Question: Briefly state, in one sentence, what is plotted here.
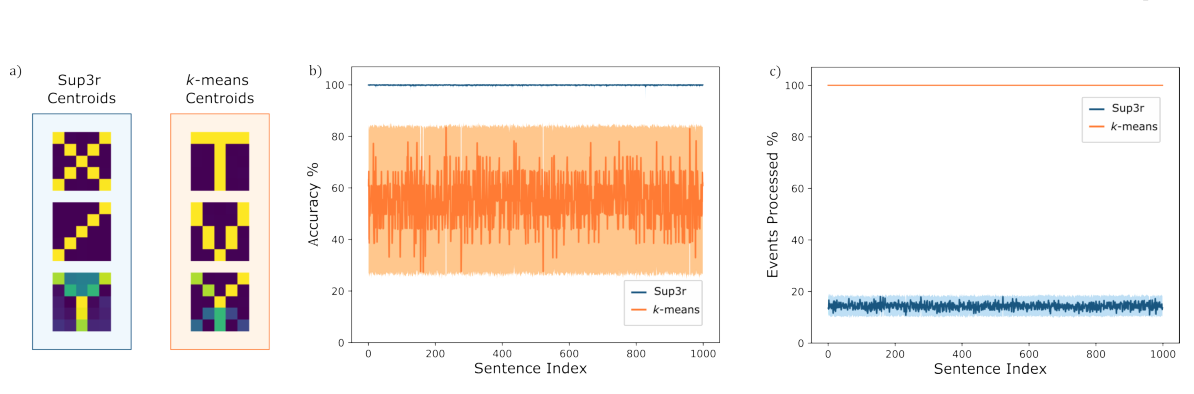
Answer: Neuromorphic benchmark results, comparing Sup3r against k-means for feature extraction. a) Layer 1 features extracted with k-means (light blue) and Sup3r (orange). k-means fails to extract class-relevant features, while Sup3r can correctly extract ”x” ”/”, leaving one centroid unused. b) Consequently, k-means fails the classification task, performing close to the chance level (≈55.36% accuracy, calculated as the percentage of events assigned to the correct class), while Sup3r can solve the task with ≈99.92% accuracy. Since Sup3r rejects events from non-class-relevant characters, only ≈14.33% of events are propagated in the network (calculated as the ratio between the number of the last layer output events divided by the number of the first layer input events). Conversely, the k-means network outputs the same number of input events.